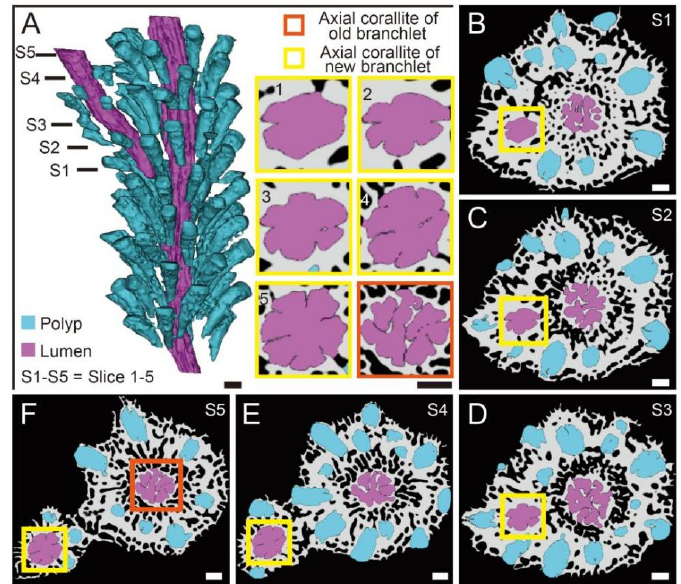
Figure 3. Three-dimensional reconstructions visualizing the axial corallite formation during branch- born processes in A. muricata . ( A ) An A. muricata branch with a newborn branchlet. ( B – F ) The S1–S5 cross-sections revealed the calice–axial corallite transformation during the birth of a new branchlet. Scale bars: 1 mm.